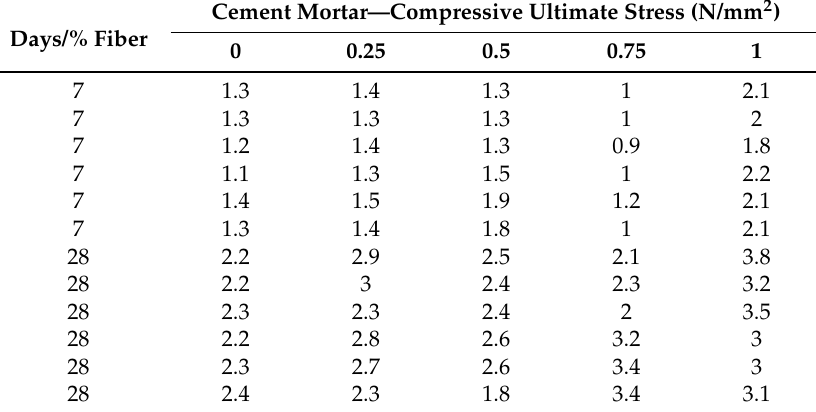
Table 3. Compression tests for cement mortar.